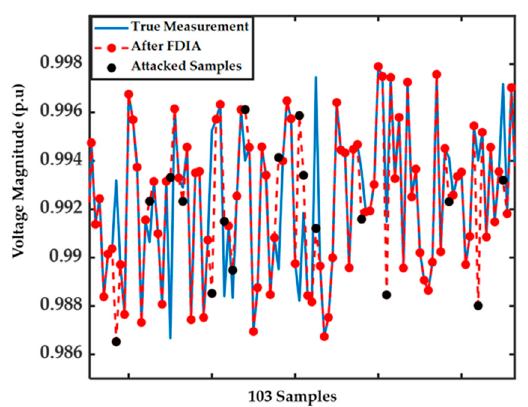
Figure 7. Original and attacked measurements for 103 samples when z a = ∼ N ( µ z , σ z )